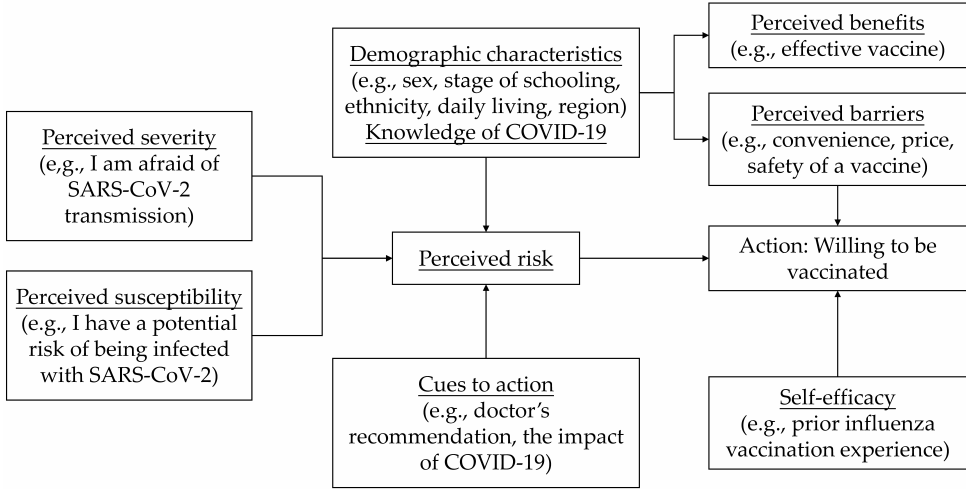
Figure 2. Components of theory of a health belief model as applied to COVID-19 vaccine willingness, hesitancy, or resistance in Chinese